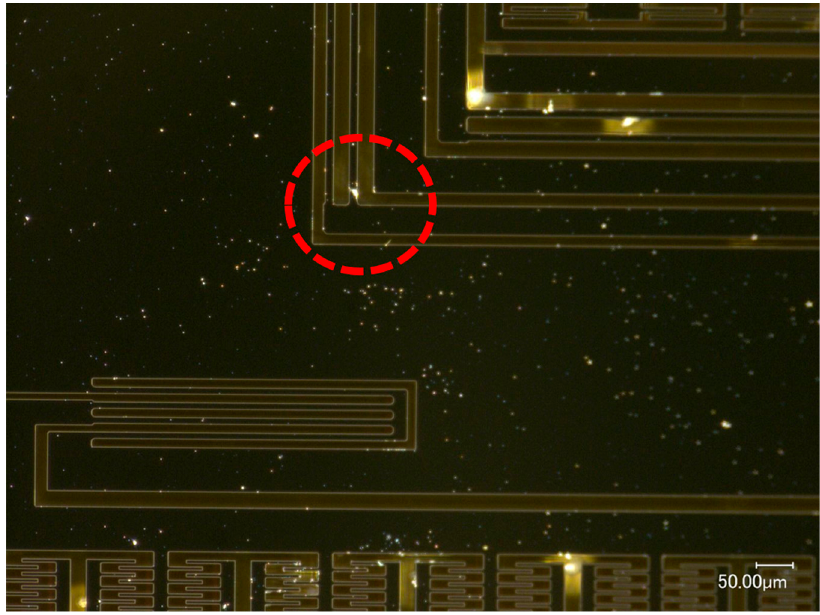
= 25,000 g, τ = 50 µ 0